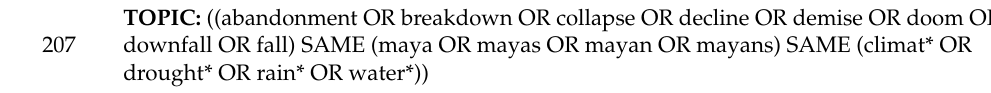
Table A1. WoS search query, date of search: 17 January